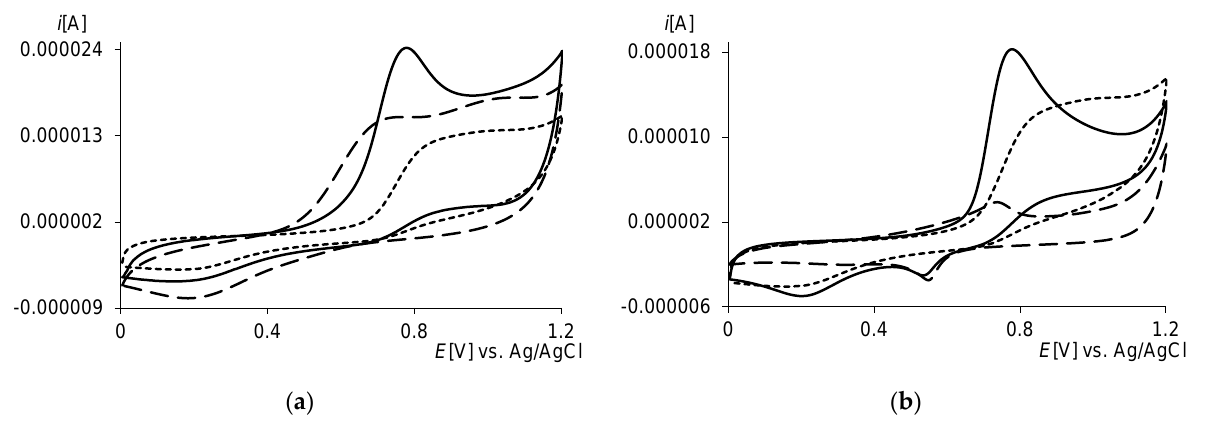
Figure 4. Cyclic voltammograms, 2nd scans, v = 0.05 V s – 1 , vs. Ag/AgCl. Modified electrodes in NaClO 4 /NaOH(0.1 mol·dm −3 )/H 2 O (after electropolymerization: 3 scans, v = 0.05 V s – 1 ) — dashed lines, modified electrodes in NO 2 – (10 – 3 mol·dm − 3 )/NaClO 4 /NaOH/H 2 O — solid lines; Pt in NO 2 – /NaClO 4 /NaOH/H 2 O — dotted lines. ( a ) Pt poly [Ni(salcn)], ( b ) Pt poly [Ni(salcn(Bu))].